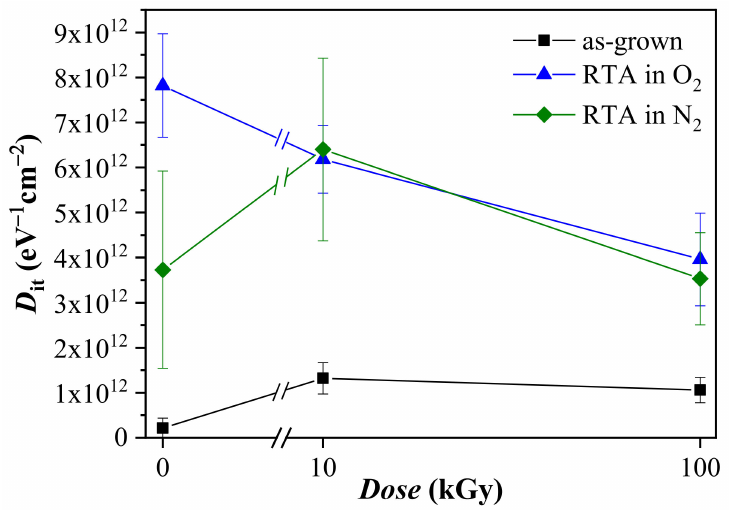
Figure 2. The density of the fast interface states at flat-band before and after